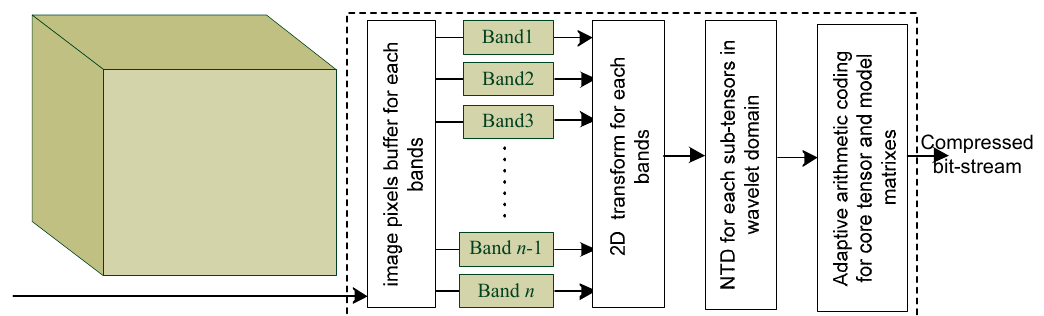
Figure 1. Schematic of multispectral compression based on